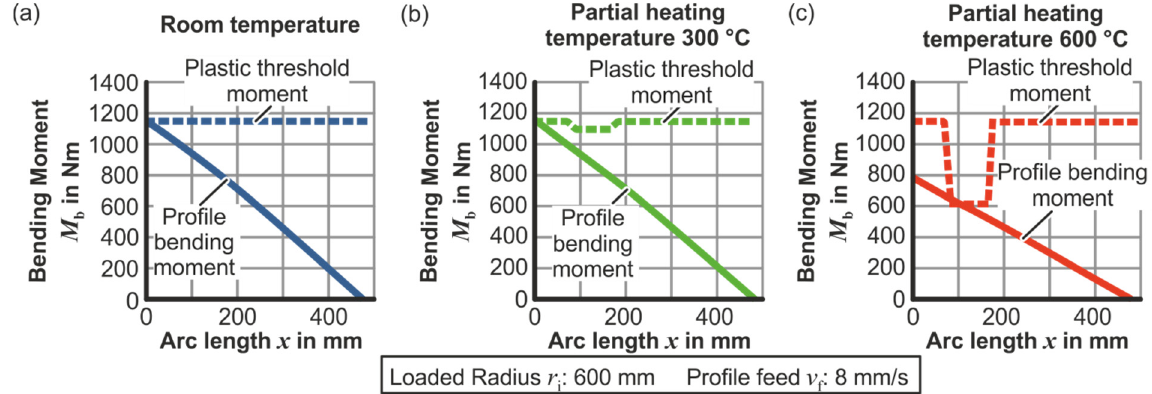
Figure 11. Bending moments and plastic threshold bending moments for room temperature ( a ), 300 °C partial heating temperature ( b ) and 600 °C partial heating temperature ( c ) case resulting from mechanical equilibrium and flow stress for the loaded radius.